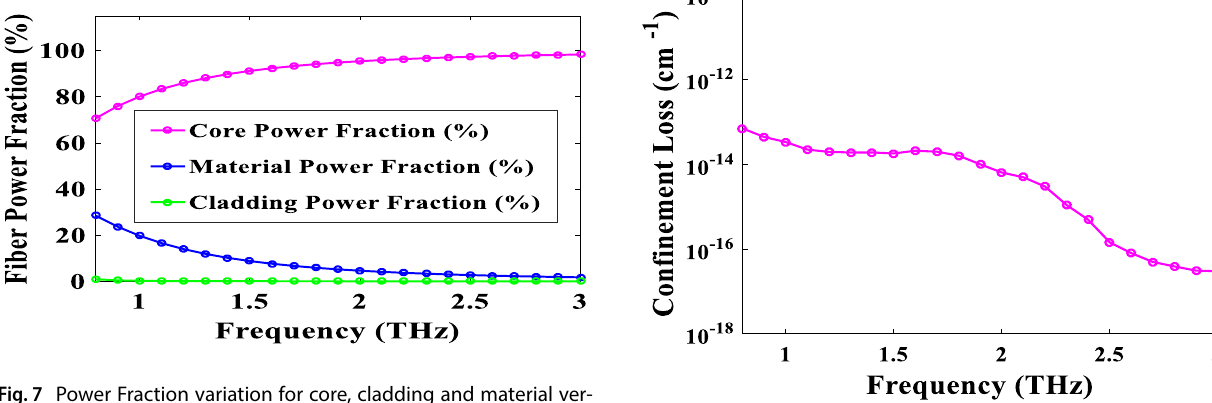
Fig. 7 Power Fraction variation for core, cladding and material ver- sus frequency at THz region